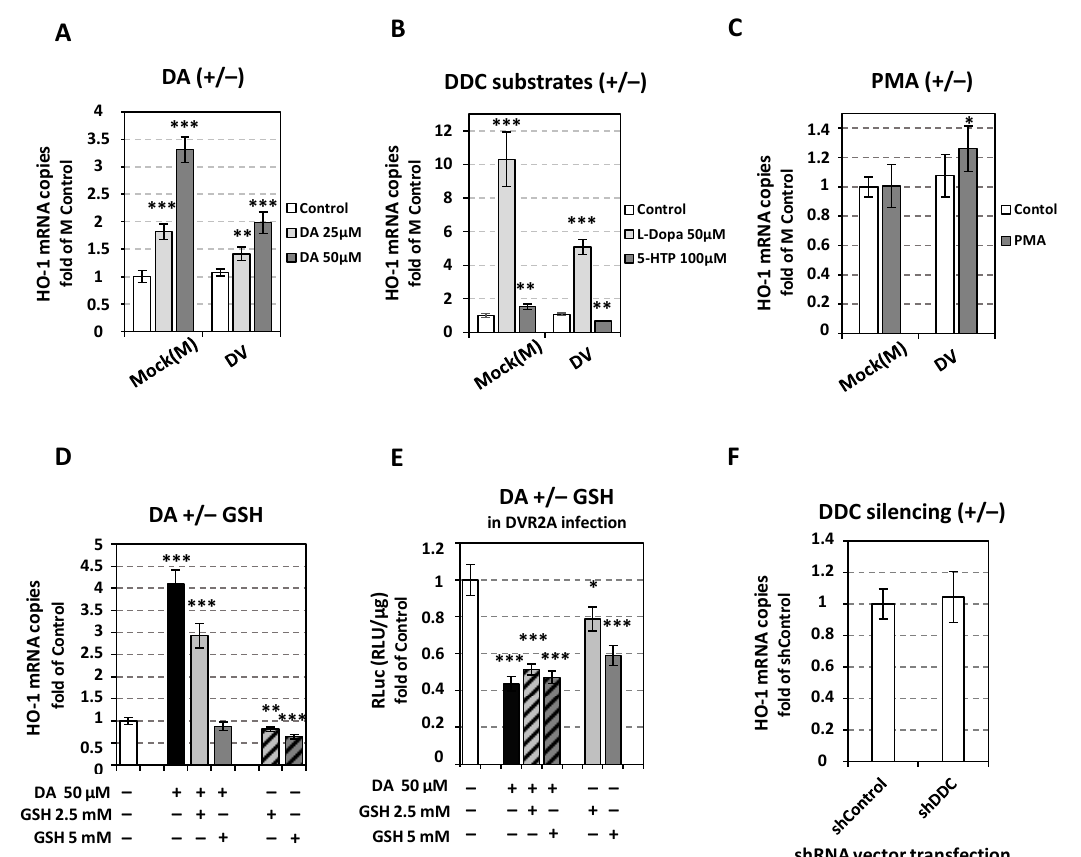
Figure 11. Effect of catecholamine biosynthesis and metabolism pathway on HO-1 mRNA levels, a cellular redox homeostasis marker. ( A – E ) Huh7 cells were inoculated with DV ( A – C ) (MOI = 0.1), or DVR2A ( E ) (MOI = 0.1) or were mock-infected (mock, M) for 4 h, and then treated with the appropriate concentrations of DA ( A , D , E ), L-Dopa, 5-HTP ( B ), PMA ( C ), GSH ( D , E ), or were mock- treated (Control), for 48 h. ( A – D ) RT-qPCR analysis was performed to determine the mRNA amounts of HO-1. The mRNA levels of the housekeeping gene YWHAZ were used for normalization. Mock- infected mock-treated cells (M Control) ( A – C ) or infected mock-treated (Control, ( − )) cell ( D , E ) values were set to one. ( E ) Renilla luciferase activity was quantified. Control ( − ) cell values were set as one. ( F ) RT-qPCR analysis was performed to determine the mRNA levels of HO-1. Lysates from Huh7.5 cells stably expressing shDDC or shControl were used. shControl-expressing cell values were set as one. The mean values ± standard deviations from three independent experiments in triplicate are featured. * p < 0.05, ** p < 0.01, *** p < 0.001 vs. M Control for ( A – C ) or Control ( − ) for ( D , E ). Thus, while on the one hand catecholamines negatively affected DV replication in hepatoma cells, on the other hand these molecules increased ROS levels, as deduced by the upregulated HO-1 expression, a condition that has been shown to favor DV replication. This suggests that catecholamines affect DV through a different mechanism unrelated to redox status of the cell. In support of this, reduced glutathione (GSH) although